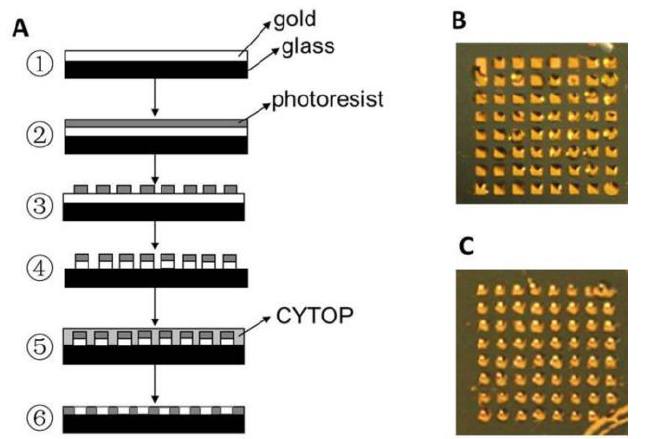
Figure 9. ( A ) Fabrication procedure for fabricating gold-islanded biochip with hydrophilic / hydrophobic spacer: ① gilding, ② photoresist spin-coating, ③ patterned exposure and developing, ④ gold etching, ⑤ CYTOP spin-coating and baking, ⑥ stripping excessive CYTOP and photoresist; ( B ) Image of the chip wetted by water; ( C ) Image of the chip dropped with hydrophilic samples. Reproduced with permission from [75]. Copyright American Chemical Society, 2017.